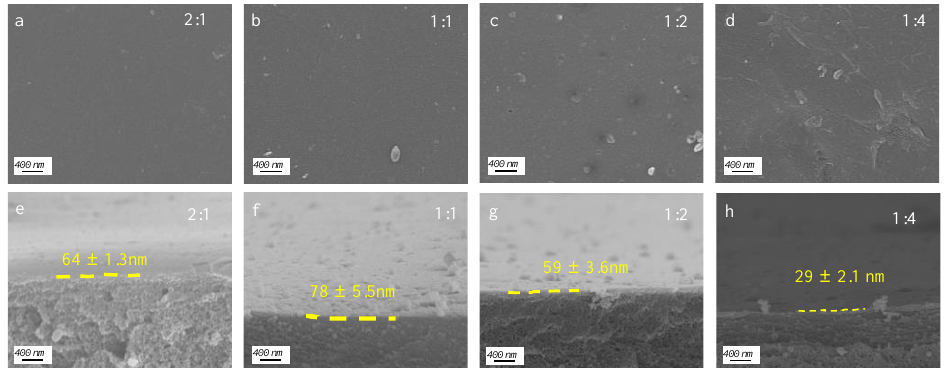
Figure 2. SEM images of PAN UF membrane: ( a ) surface morphology and ( b ) cross-section mor- buffer solution. At pH = 8.0 and pH = 8.5, the top layer thickness is ~35 nm, higher than phology of PAN UF membrane. that of 22 nm at pH = 7.0 (Figure 4e–g).